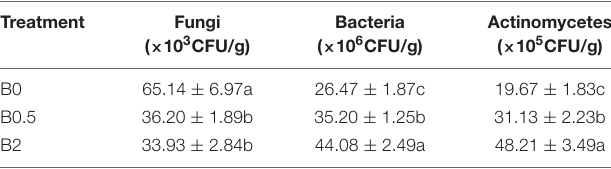
TABLE 2 | Effects of biochar amendment on soil microbial communities.